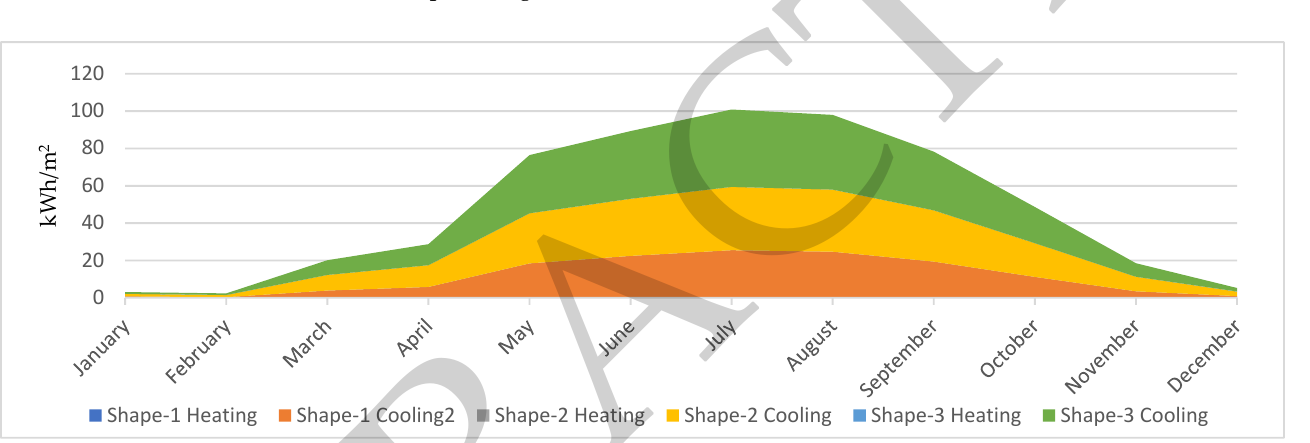
Figure 15. Monthly heating and cooling energy consumption in Shenzhen.